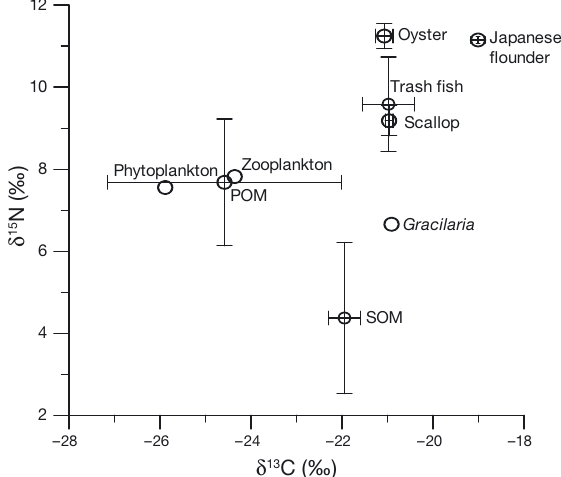
Fig. 3. Carbon and nitrogen contents (% dry wt) and C/N ra- tios of cultured species (seaweed, shellfish and fish; see Table 1) and of phyto- and zooplankton and input feed (i.e trash fish) in Sanggou Bay during the wet season. Means ± SD